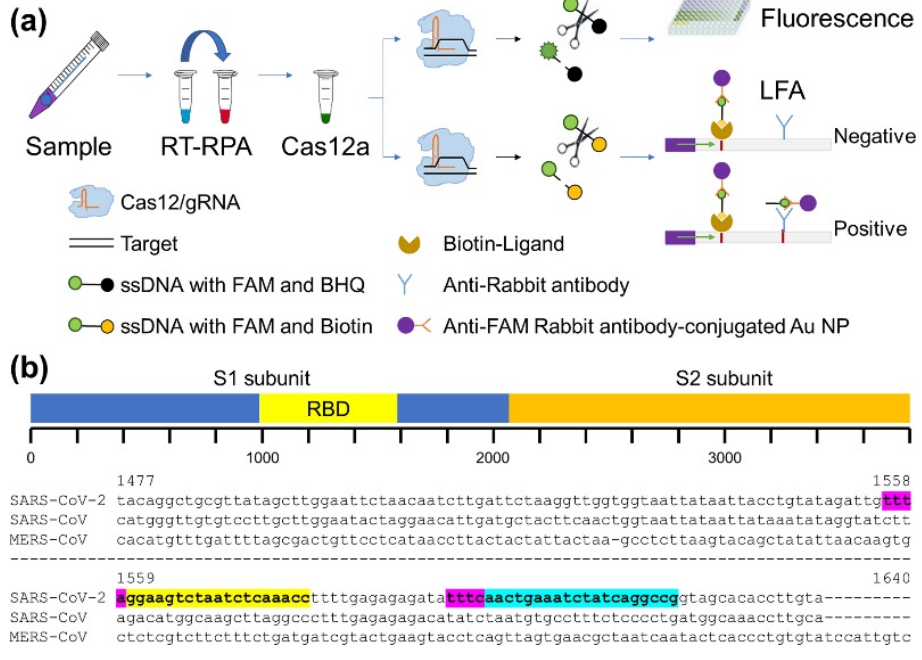
Figure 1. ( a ) Schematic representation of CRISPR-Cas12-based assay for SARS-CoV-2. ( b ) Sequence alignment of RBD region of S gene in SARS-CoV-2, SARS-CoV, and MERS-CoV. Regions colored in yellow and sky blue indicate SARS-CoV-2-specific T1 and T2, respectively, next to PAM sequence, marked in